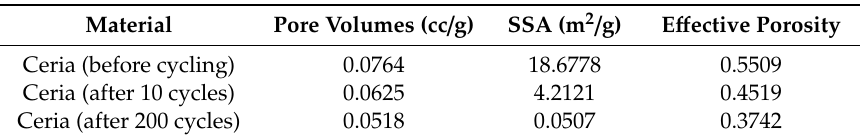
Figure 11. SEM images of the porous ceria pellet after 200 cycles: ( a ) near the edge; ( b ) between the edge and the center; ( c ) near the center; ( d ) near the center with low magnification. All images are at 1000 × magnification except ( d ), which is at 250 × magnification. Table 2. Total pore volumes, specific surface area (SSA) and e ff ective porosity of ceria before cycling, after 10 cycles and after 200 cycles from mercury intrusion porosimetry (MIP) analysis at high-pressure configuration.